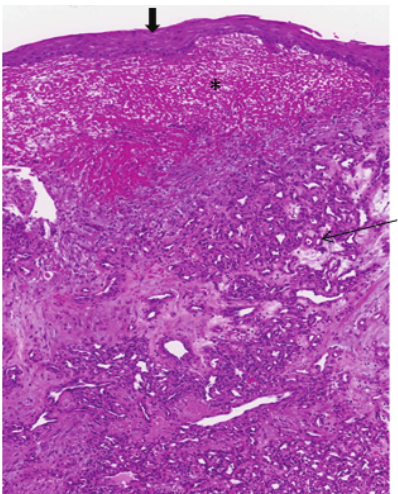
Figure 3: A nodular lesion with squamous metaplasia (marked downwards thick arrow) of the surface epithelium, underlying fibrinous exudates (marked ∗ ), and a florid proliferation of small capillaries (marked → ) surrounded by fibrous stroma on 10x Hematoxylin and Eosin